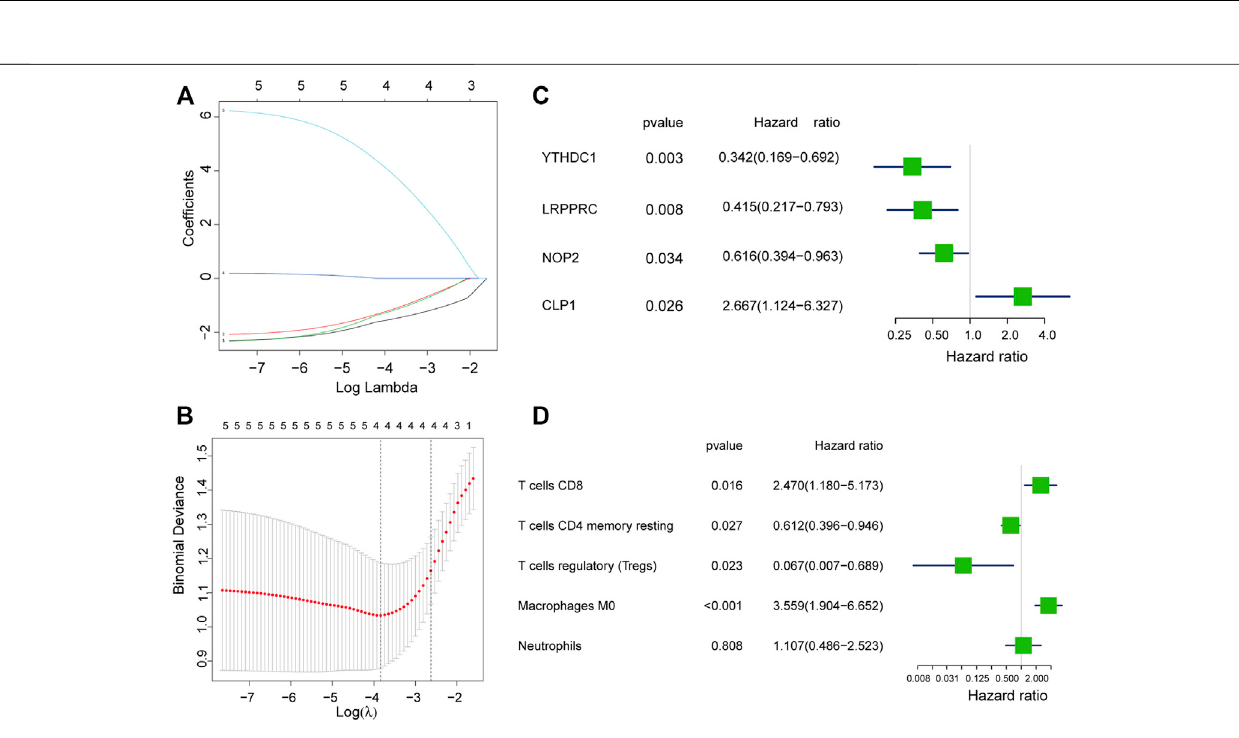
Frontiers in Pharmacology |